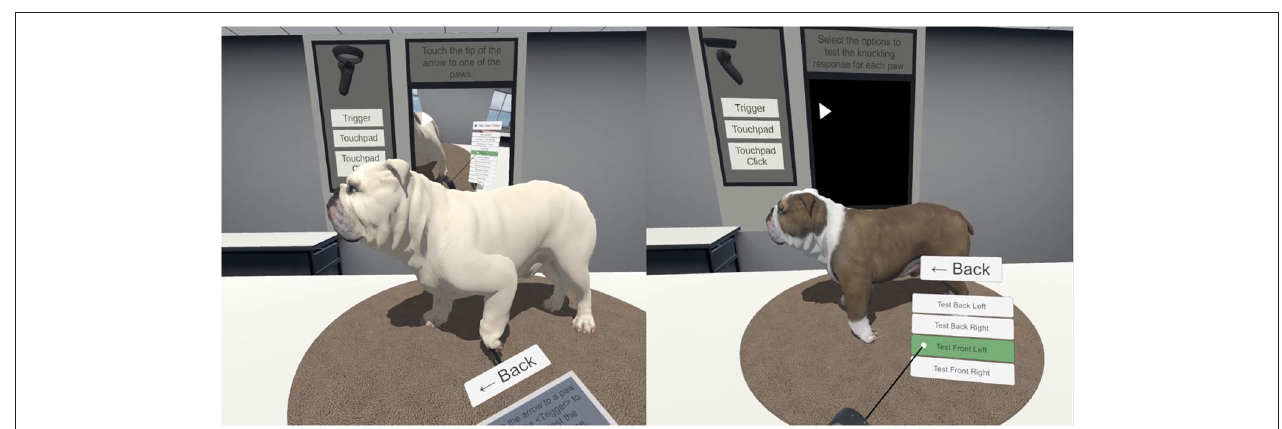
FIGURE 4 | (Left) The RBI mode for the placing test. The participant is manipulating the position of the paw directly with the controller. (Right) The CMD mode for the same test. This dog also has the alternate fur coloring. Note the screen on the back wall that can display a tutorial video and the model of the controller with reminders of the button